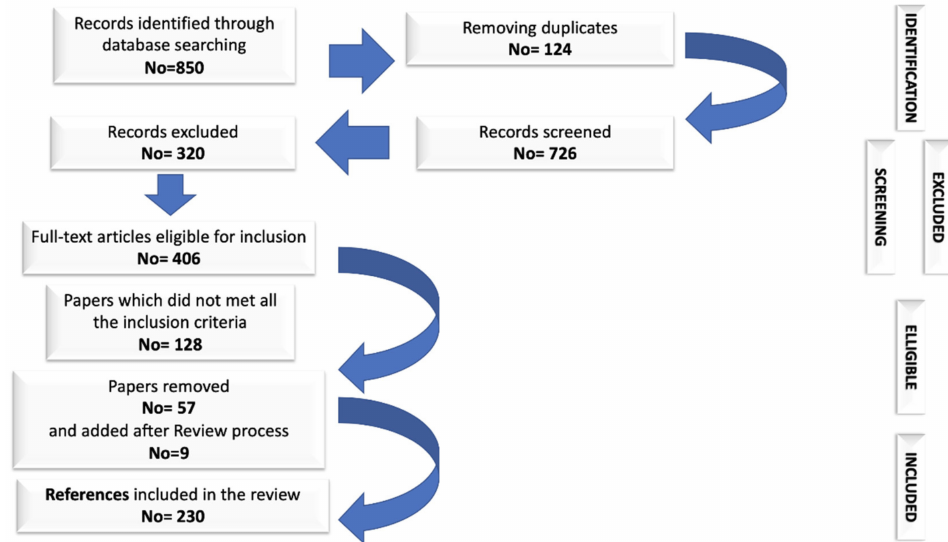
Figure 1. Flow chart of the selection process of the bibliographic sources included in this